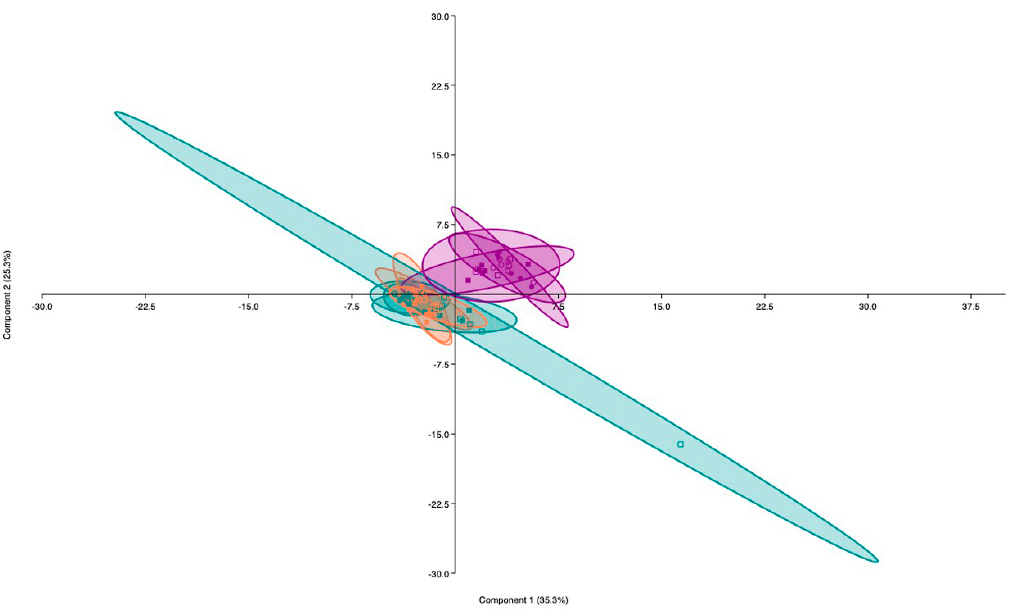
Figure 2. Principal components analysis (PCA) for data corresponding to the urea experiment. Plot with data run in PAST software, showing the two principal components (PC1 and PC2) which separated the samples by urea level. Blue color corresponds to no N treatments, orange color correspond to low N treatments and purple color to high N treatments. Solid circles represent non-AM plants under WW, solid squares represent non-AM plants under DS (during 14 days), empty circles represent AM plants under WW and empty squares represent AM plants under DS.